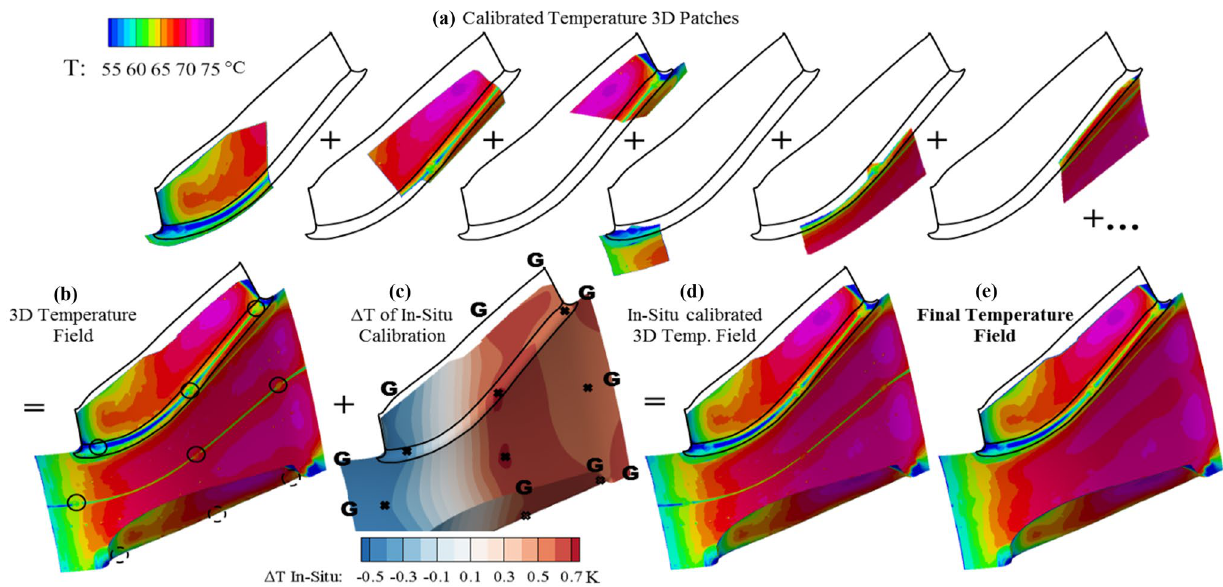
Fig. 6 Temperature postprocessing: from the set of calibrated temperature 3D patches to the final temperature